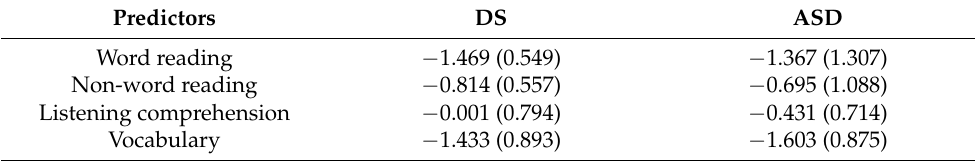
Figure 4. Listening comprehension predicting reading comprehension. Table 2. Mean z-scores (standard deviations) for each predictor in the two atypical